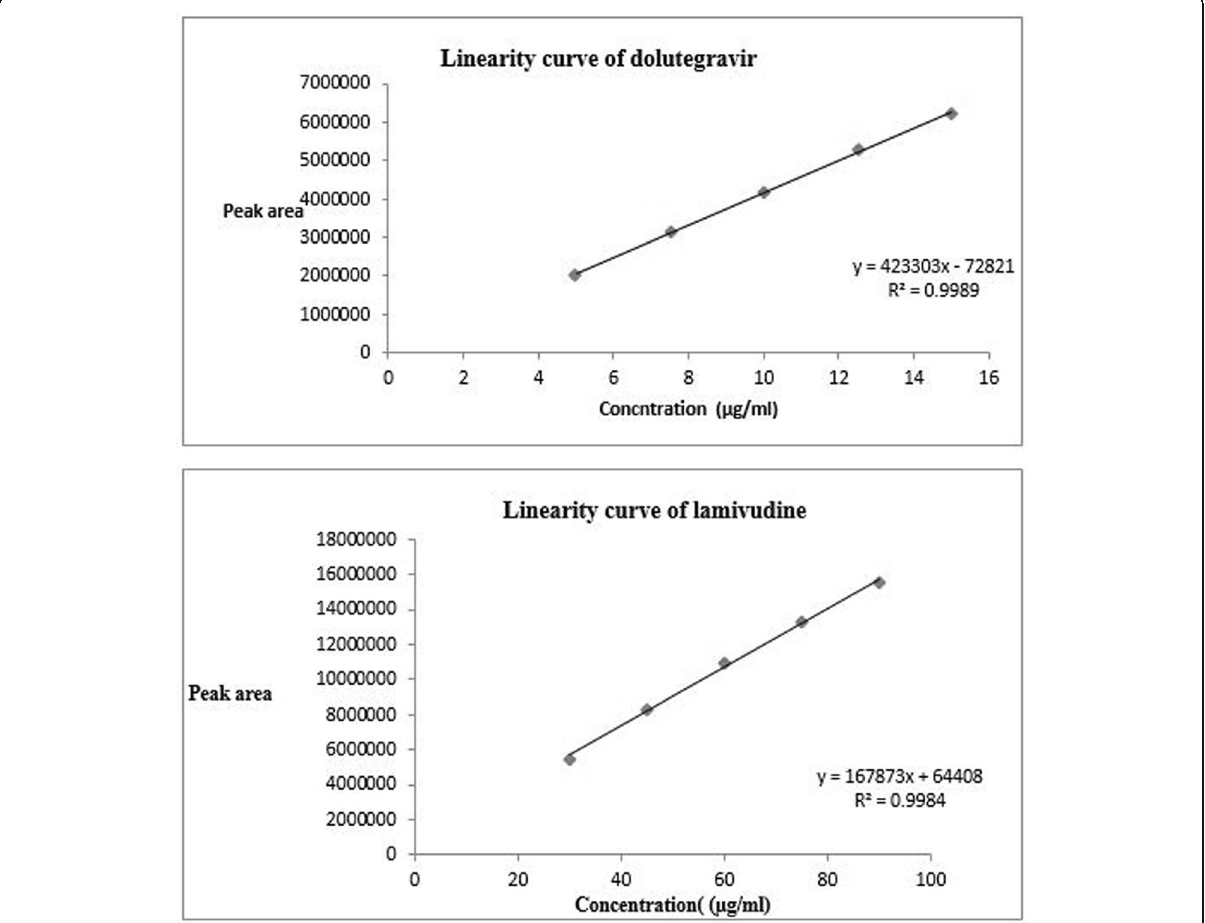
Fig. 3 Calibration curve of Dolutegravir and